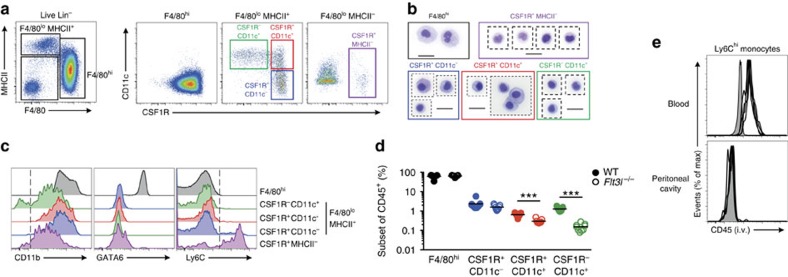
Phenotypic characterization of peritoneal myeloid cells.(a) Expression of F4/80 and MHCII by live CD45+Lin− (CD3, CD19, Ly6G, SiglecF) peritoneal exudate cells (PEC) obtained from naïve adult WT mice (left panel) and expression of CD11c and CSF1R by F4/80hi, F4/80loMHCII+ and F4/80loMHCII− cells (right panel). Data are representative of at least 20 independent experiments. (b) Morphological appearance of F4/80hi, F4/80loMHCII+ subsets and F4/80loMHCII− cells purified from naive adult WT mice. Scale bar, 20 μm. Images are from one experiment performed. (c) Expression of CD11b, GATA6 and Ly6C by PEC myeloid subsets as gated in a. Histograms are representative of at least six (GATA6) or 20 (CD11b and Ly6C) independent experiments. (d) Frequency among CD45+ leukocytes of F4/80hi macrophages and CD11c/CSF1R-defined F4/80loMHCII+ subsets in PEC of naive 8-week old WT (n=9) or Flt3l−/− (n=9) mice. Data are pooled from two independent experiments. Each symbol represents an individual animal and horizontal bars represent the mean. ***P<0.0001 determined by Student's t-test followed by Holm-Sidak correction. (e) Expression of CD45 by Ly6C+ monocytes in blood and peritoneal cavity of WT mice administered anti-CD45 i.v. 2 min before necropsy. Each line represents an individual mouse (n=4) and shaded histograms represent uninjected control mice. Data representative of four independent experiments.